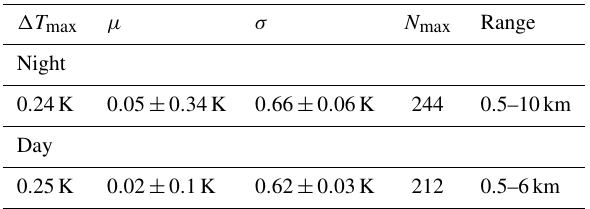
Table 5. Summary of the statistical parameters of the day and night (cid:49)T